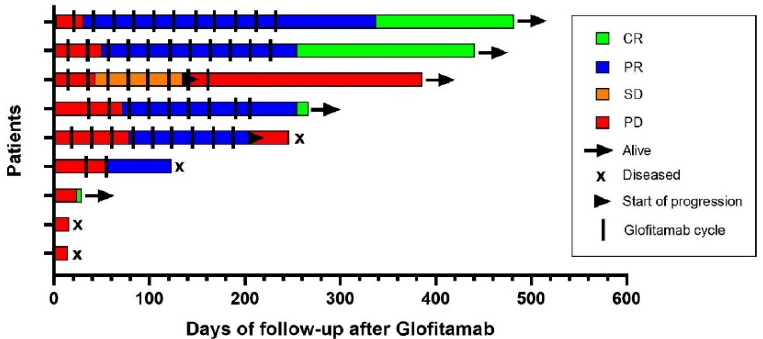
Figure 2. Swimmer plot illustrating outcomes after glofitamab therapy.